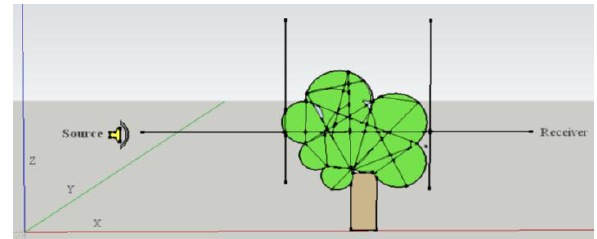
Figure 12. Determination of through-tree length (path length intercepted by tree cluster)